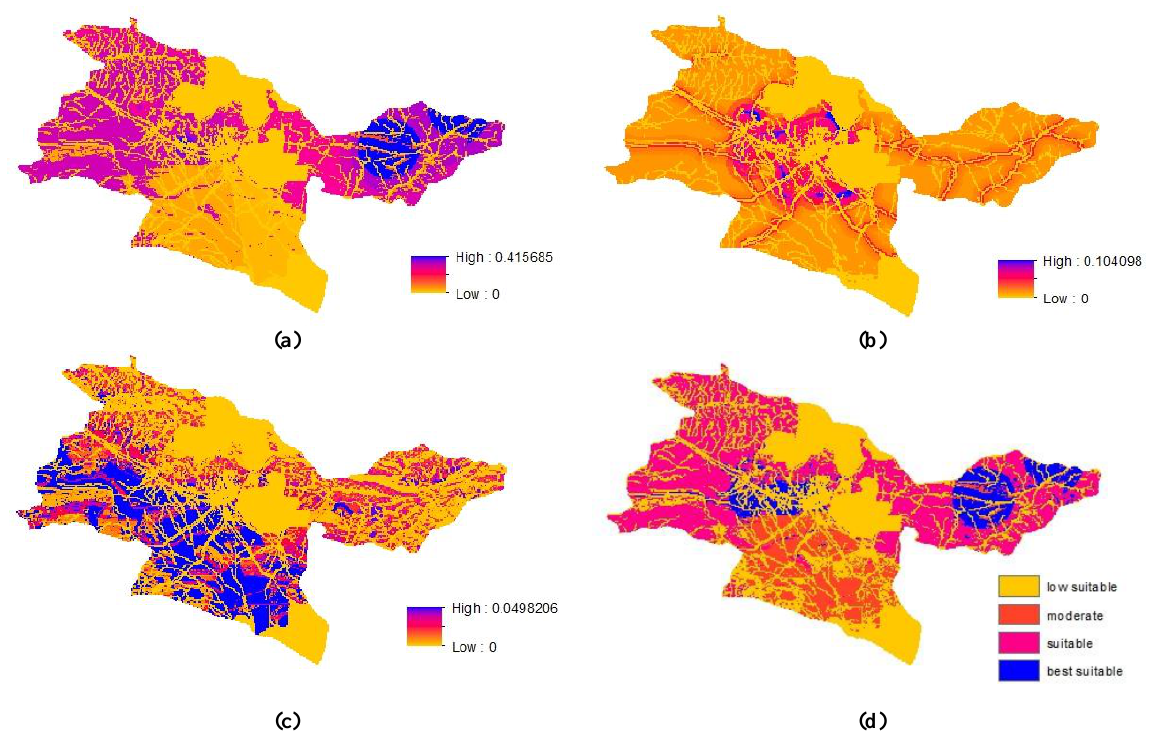
Figure 4. LSI for (a)climatic (b)location (c)geomorphological factors. (d) final suitability map for solar farm site